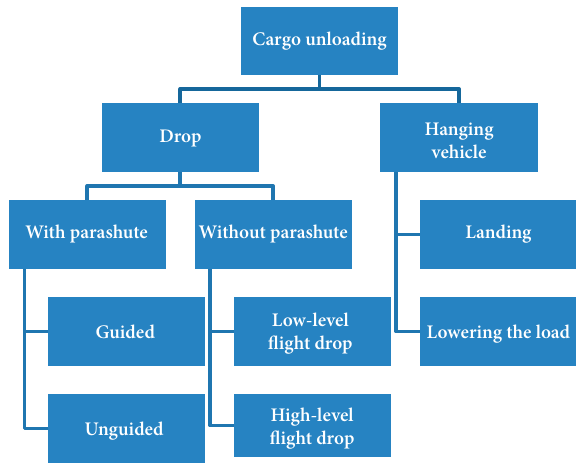
Fig. 7. Cargo delivery